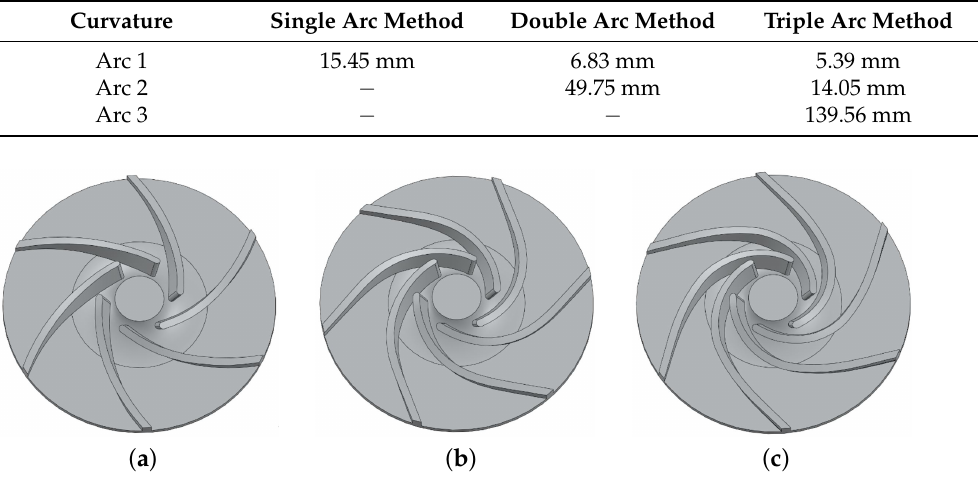
Figure 15. Impeller configurations based on different design methods: ( a ) single arc method; ( b ) dou- ble arc method; ( c ) triple arc